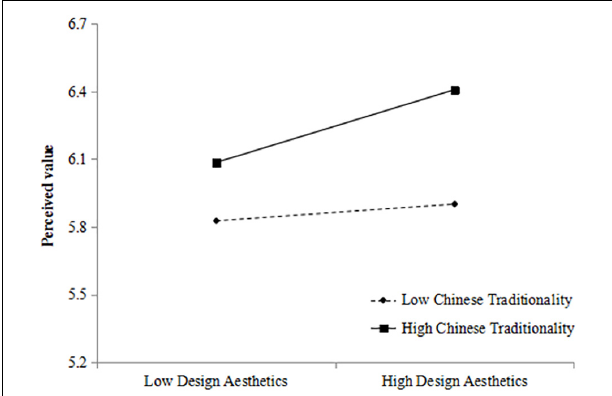
FIGURE 2 | Interaction of design aesthetics and Chinese traditionality on perceived